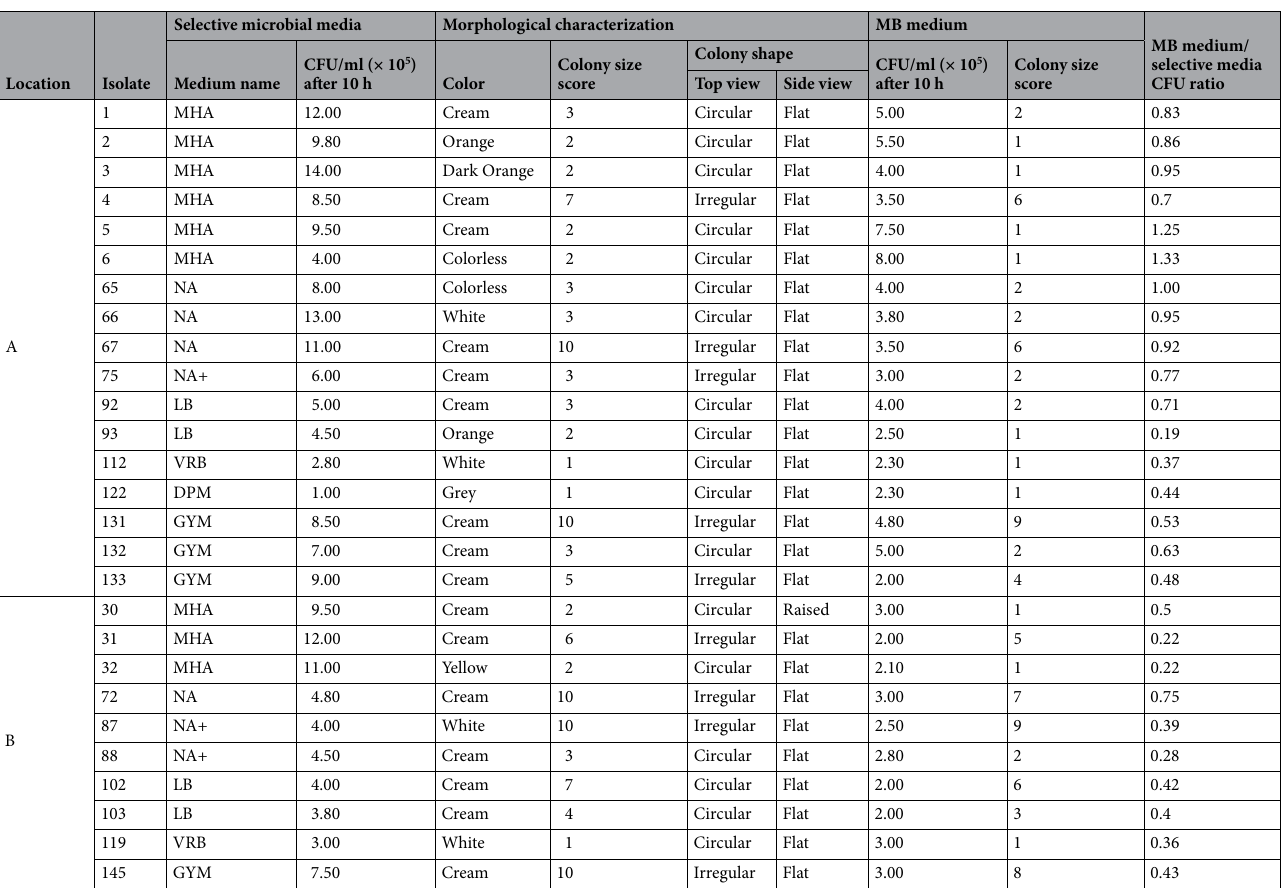
Table 2. Effect of two coastal deserts on microbial growth parameters and morphological characterization of soil bacteria isolated from locations A and